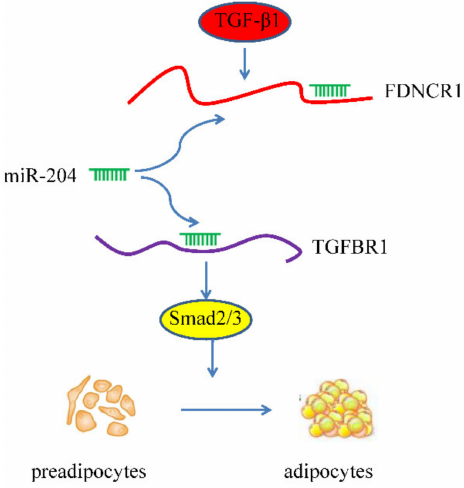
Figure 6. Model of the possible FDNCR1-miR-204-TGFBR1 pathway in porcine preadipocyte di ff